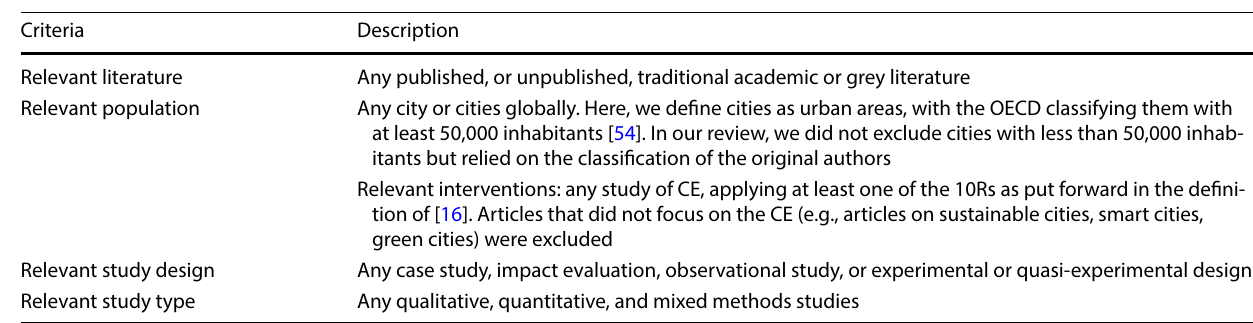
Table 3 Inclusion criteria